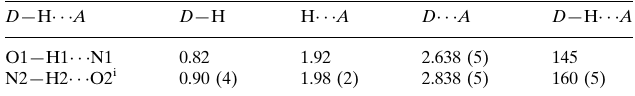
Hydrogen-bond geometry (A˚ , (cid:1)